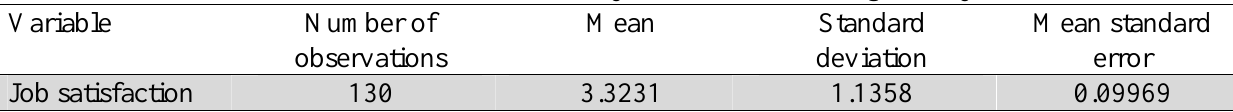
The results of some basic statistics on the level of job satisfaction for high-risk jobs